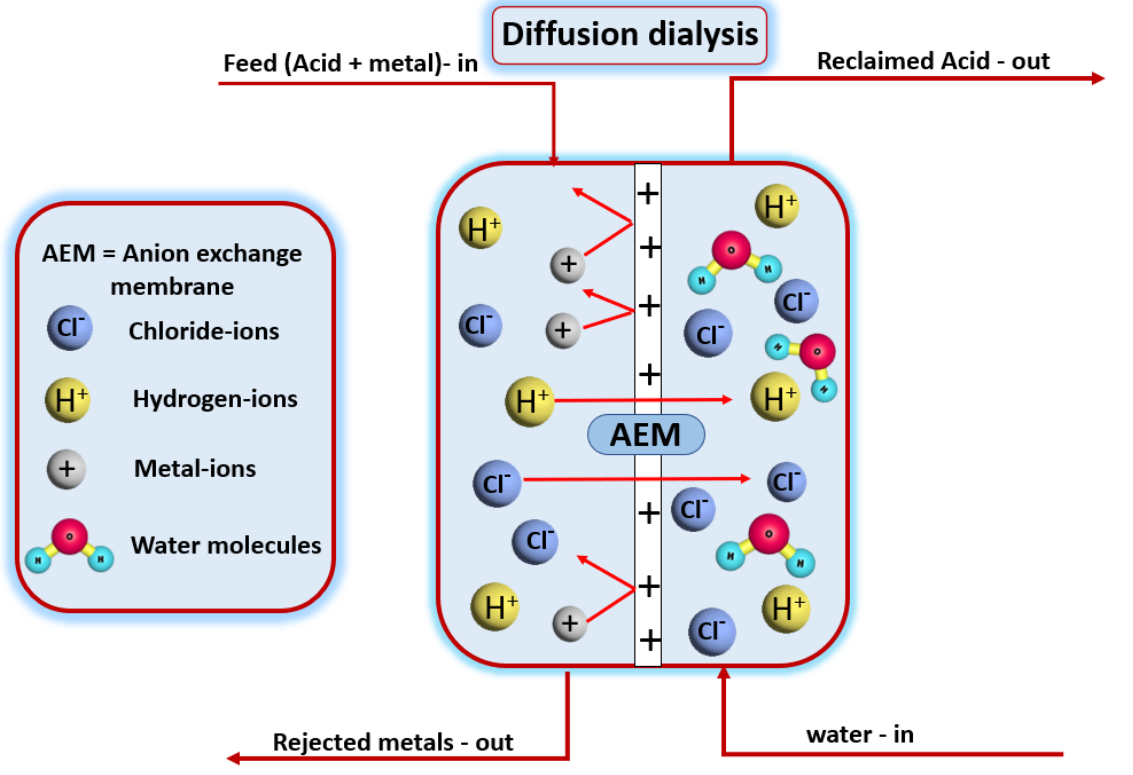
Figure 1. Graphical representation of the diffusion dialysis process through the anion exchange membrane separation process of HCl from its inlet feed solution.